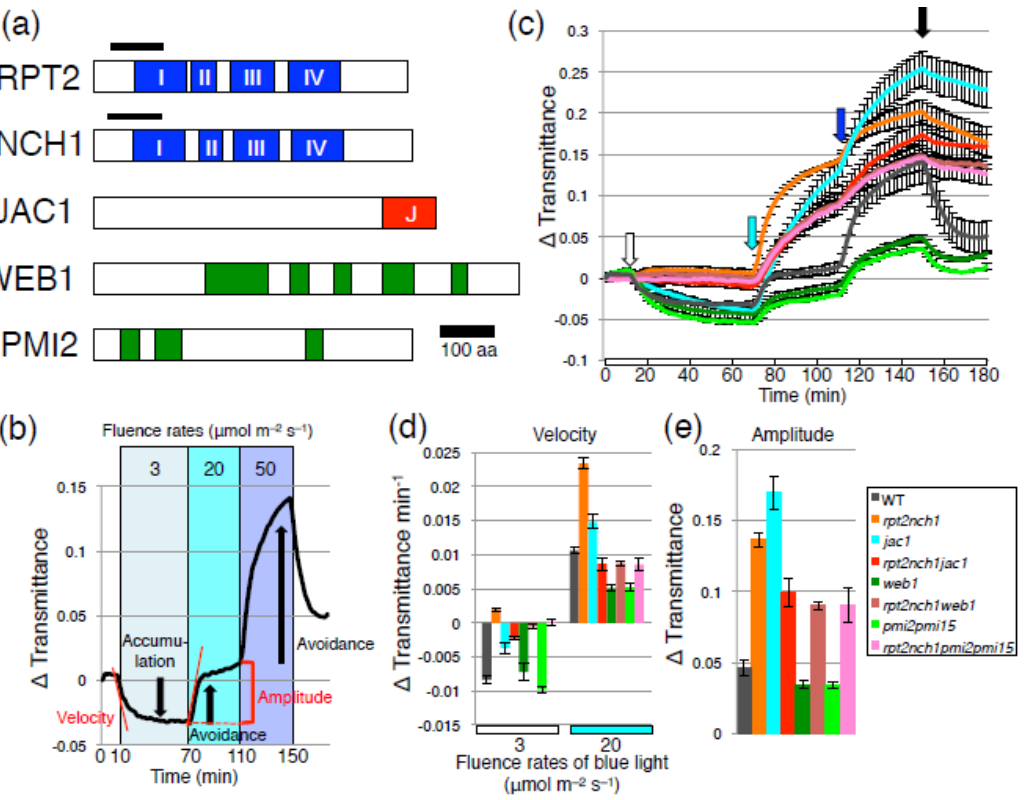
Figure 1. ( a ) Protein structure of ROOT PHOTOTROPISM 2 (RPT2), NRL PROTEIN FOR CHLOROPLAST MOVEMENT 1 (NCH1), J-DOMAIN PROTEIN REQUIRED FOR CHLOROPLAST ACCUMULATION RESPONSE 1 (JAC1), WEAK CHLOROPLAST MOVEMENT UNDER BLUE LIGHT 1 (WEB1), and PLASTID MOVEMENT IMPAIRED 2 (PMI2). Blue boxes indicate the four conserved regions of NPH3/RPT2-like (NRL) proteins. The position of the BTB/POZ domain is indicated by a black bar. Red box is a J-domain. Green boxes indicate the coiled-coil domains; ( b ) Measurement of light-induced changes in leaf transmittance as a result of chloroplast photorelocation movements. The depicted trace represents typical data collected for wild type under the various light irradiation conditions (indicated by color boxes). There is a decrease in leaf transmittance in response to 3 μmol m −2 s −1 of blue light, indicating that the accumulation response is induced ( downward arrow ). Conversely, there is an increase in leaf transmittance in response to 20 and 50 μmol m −2 s −1 of blue light, indicating that the avoidance response is induced ( upward arrows ). Red lines mark the initial linear fragments of leaf transmittance rate change during the first 2–6 min of the irradiation period, indicating the velocity. A red parenthesis marks the difference between the transmittance level observed following 60 min of 3 μmol m −2 s −1 blue-light irradiation and the transmittance level observed a following further 40 min of 20 μmol m −2 s −1 blue-light irradiation, indicating the amplitude of the avoidance response caused by 20 μmol m −2 s −1 blue-light irradiation; ( c – e ) Distinct chloroplast movements observed between rpt2nch1 and jac1 ; ( c ) Light-induced changes in leaf transmittance of the indicated lines were measured using a custom-made plate reader system [14]. The samples were sequentially irradiated with 3, 20 and 50 μmol m −2 s −1 of continuous blue light. The beginning of each irradiation period is indicated by white , cyan and blue arrows, respectively. The light was extinguished after 150 min ( black arrow ); ( d ) The velocity of light-induced transmittance changes. ( e ) The amplitude of the avoidance response caused by 20 μmol m −2 s −1 blue-light irradiation. Data for wild type, rpt2nch1 , jac1 and rpt2nch1jac1 from Suetsugu et al. (2016) [12] were used for comparison, because data for web1 , rpt2nch1web1 , pmi2pmi15 and rpt2nch1pmi2pmi15 were acquired in the same experiments using the same plate. Data are presented as means of three independent experiments and the error bars indicate standard errors. WT, wild type.